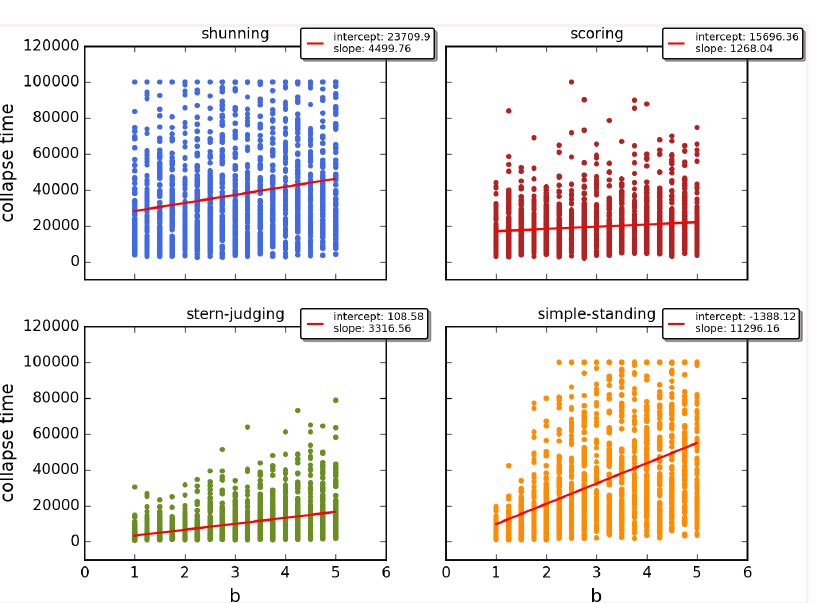
Fig 2. The time elapsed till the collapse of cooperation, MST90. The figure shows the average time until the collapse of cooperation as a function of the value of the benefit ( b ) for different social norms in the second scenario (MST90). Each symbol represents the collapse time of a single run; parameters are as follows: n = 100, c = 1, α = 1, β = 4, MST = 90%. Regression lines were fitted to visualize the relationship between collapse times and b